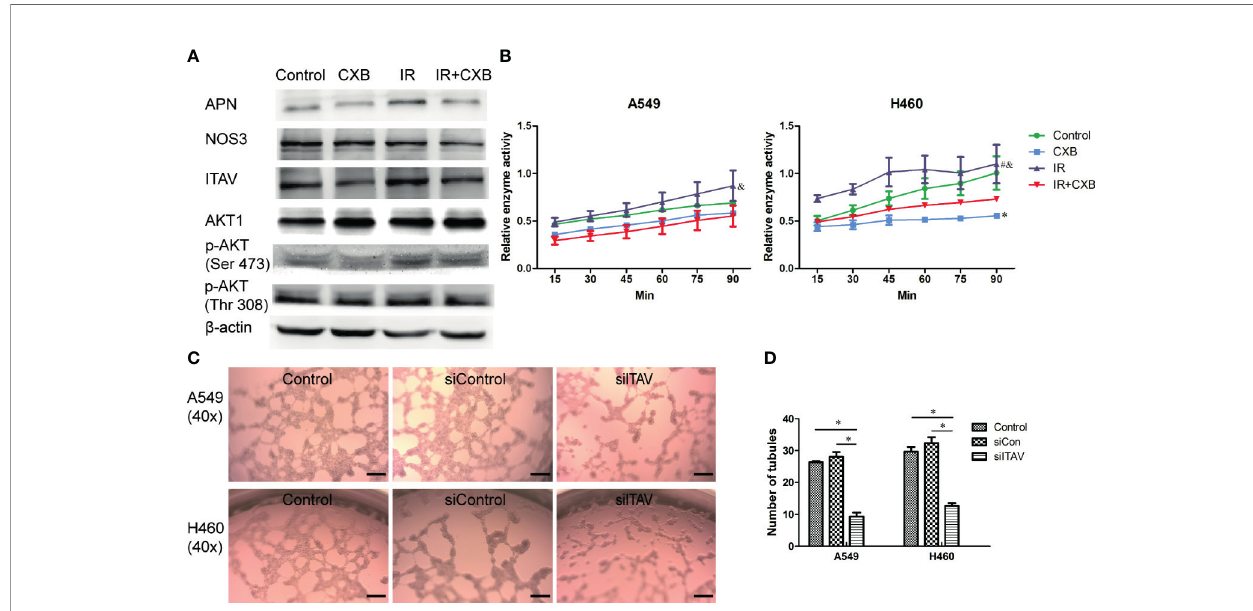
FIGURE 5 | Con fi rmation of off-targets of CXB in cells. (A) Protein expression levels assessed by Western blotting (picture was cropped). Western blotting showed that IR signi fi cantly increased ITAV and APN levels, while CXB treatment signi fi cantly decreased ITAV and APN levels. Furthermore, IR plus CXB treatment remarkably reduced the increment of ITAV and APN levels induced by IR. (B) Enzyme activity test. APN enzyme activity experiment in cells (A549 and H460). *Comparison with the control group, p < 0.05; # comparison with the CXB group, p < 0.01; & comparison with the IR plus CXB group, p < 0.01. (C) Representative images of VM formation in A549 and H460 cells transfected with non-silencing siRNA (siCon) or siRNA-ITAV (siITAV), grown on the 3D Matrigel. Scale bar, 200 m m. (D) Number of tubules. Values are expressed as mean ± SEM from three independent experiments. Inhibition of ITAV expression in cells (A549 and H460) by lentivirus transfection remarkably suppressed VM formation. * p < 0.05. CXB, celecoxib; IR, irradiation; ITAV, integrin alpha-V; APN, aminopeptidase N; VM, vasculogenic